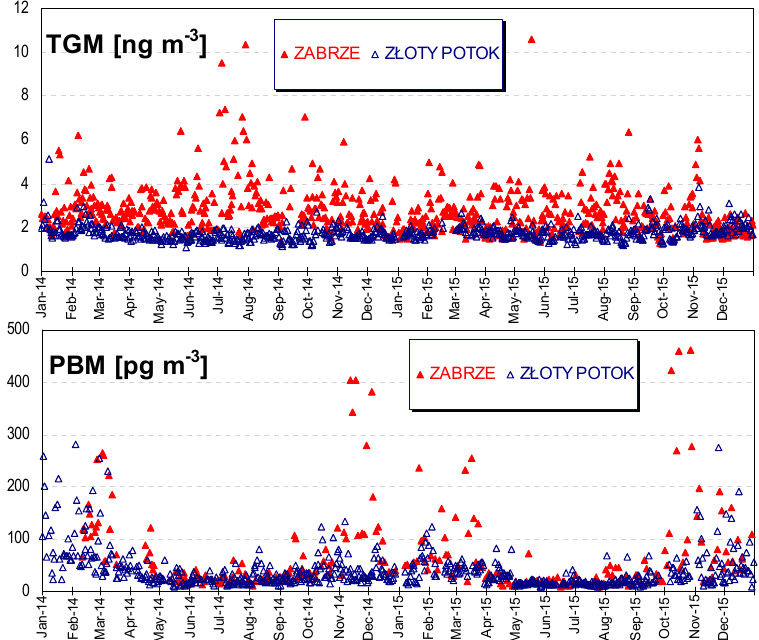
Figure 3. Daily concentrations of total gaseous mercury [TGM] and PM 2.5 -bound mercury [PBM] in Zabrze (urban background) and Złoty Potok (rural background), in the period of 2014–2015.